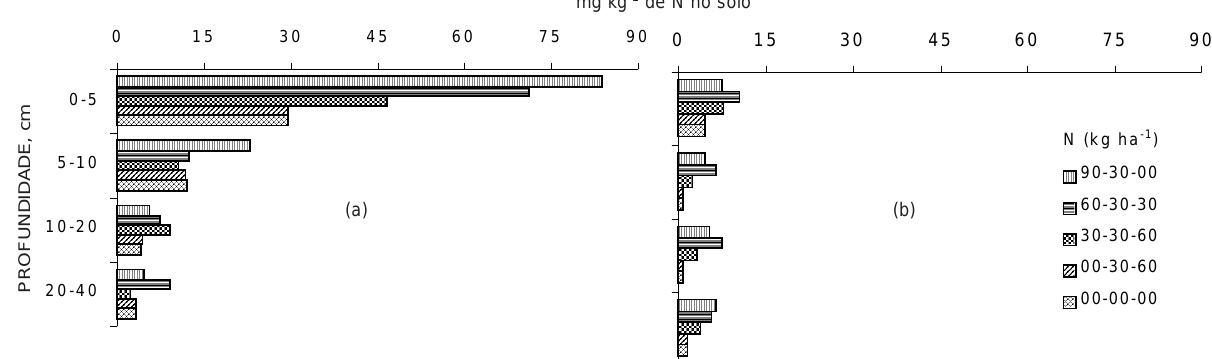
Figura 3. Teores de N mineral do solo avaliado imediatamente antes da semeadura do milho em sucessão à aveia preta, nos dois anos agrícolas, 1996/97 (a) e 1997/98